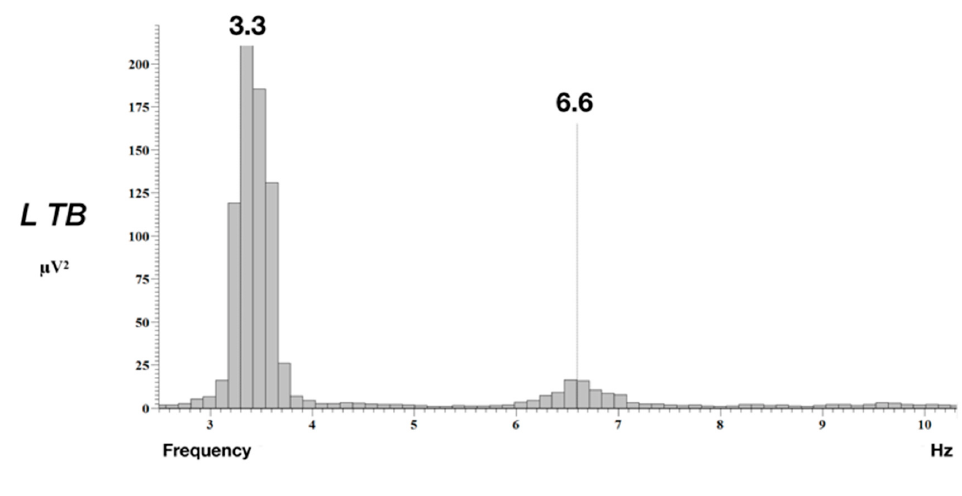
Figure 2. Quantitative analysis of a 90 s epoch of tremorogenic surface EMG recordings from the left arm whilst the patient maintains anti-gravity posture. ( A ) Cross-correlation analysis using the triceps brachii EMG channel as reference reveals a mainly out of phase relationship between the biceps and triceps brachii and a similar out of phase relationship between agonist/antagonist in the forearm. ( B ) Fast Fourier transform (FFT) shows peak frequency at 3.3 Hz and the first harmonic of the tremor at 6.6 Hz (FFT resolution 0.1 Hz). APB: abductor pollicis brevis, EDC: extensor digitorum communis,